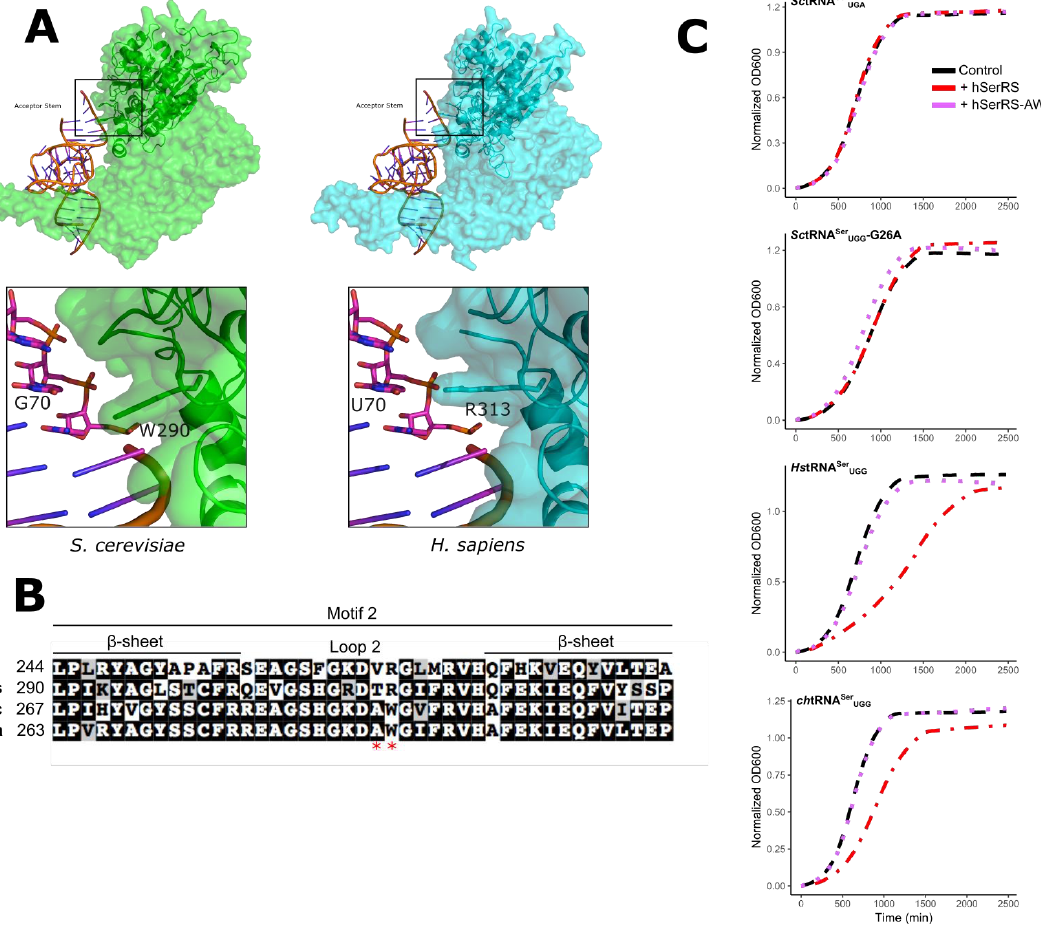
Figure 5. Sequence differences in Motif 2 of SerRS. ( A ) Model of motif 2 SerRS:tRNA Ser interactions. The yeast (green) and human (cyan) SerRS were modeled using SWISS-MODEL [55] onto the Thermus thermophilus synthetase:tRNA co-crystal structure (PDB: 1SER; [12]). The region around motif 2 is boxed and expanded in the lower images. ( B ) Sequence alignment of SerRS motif 2 sequences from T. thermophilus (WP_024119136), H. sapiens (NP_006504), S. cerevisiae (NP_010306), and Candida albicans (XP_719967) using the default settings of MUSCLE (https://www.ebi.ac.uk/Tools/msa/muscle/). The red stars mark the residues mutated to the corresponding yeast residues. ( C ) Yeast strain BY4742 containing a URA3 centromeric plasmid expressing Sc tRNA SerUGA , Hs tRNA SerUGG , ch tRNA SerUGG . or Sc tRNA SerUGG -G26A and the LEU2 multicopy plasmid YEplac181 containing myc-tagged ySerRS (black), hSerRS (red), or mutant hSerRS-AW (purple) were grown to stationary phase in media lacking uracil and leucine, diluted to an OD 600 ~ 0.1, and grown for 40 h at 30 °C. OD 600 was measured every 15 min to generate growth curves.